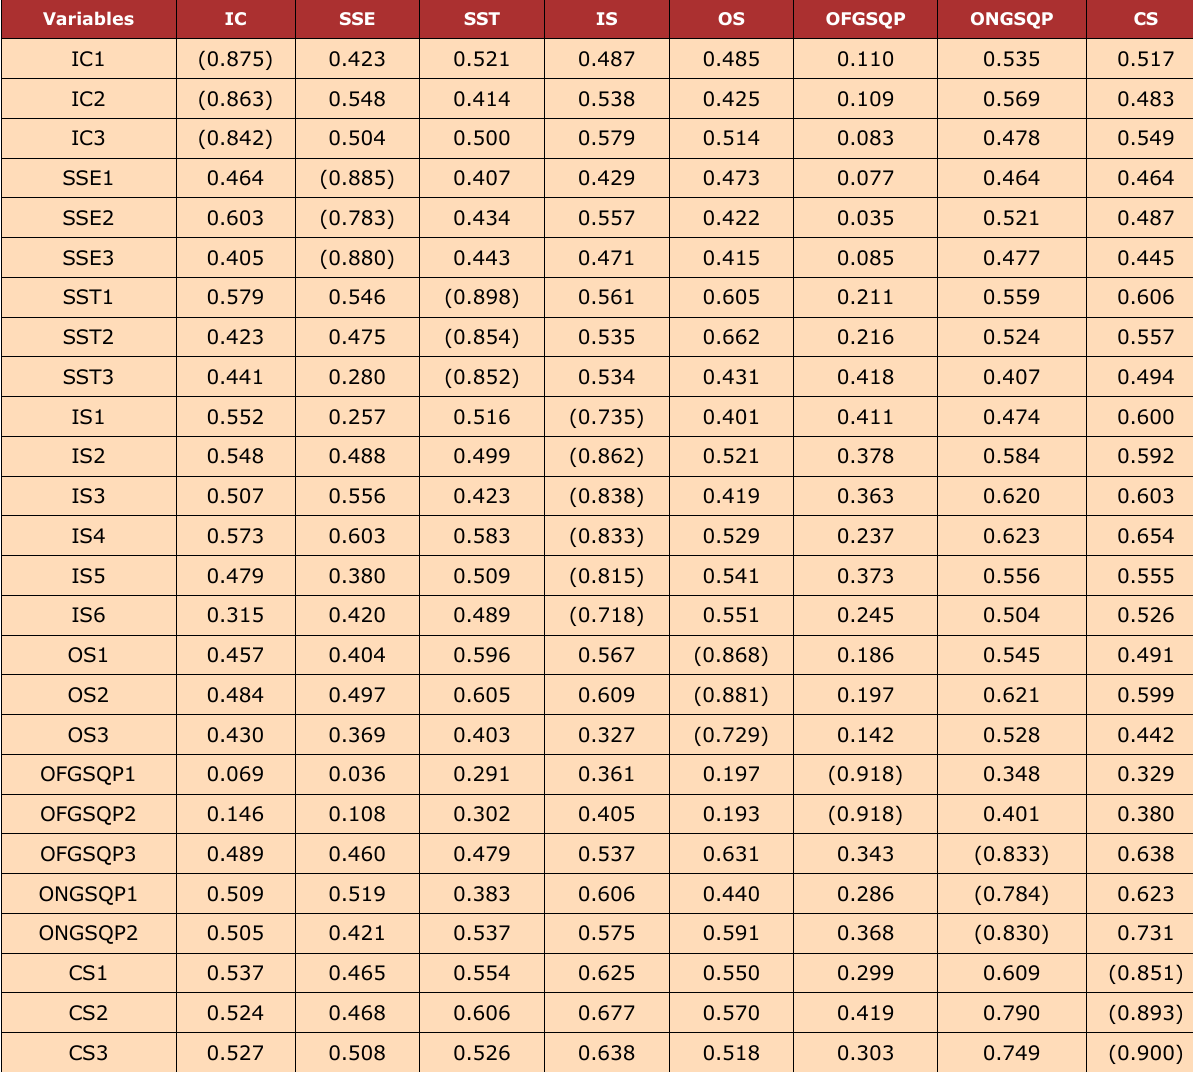
Table 5. Item Loadings and cross